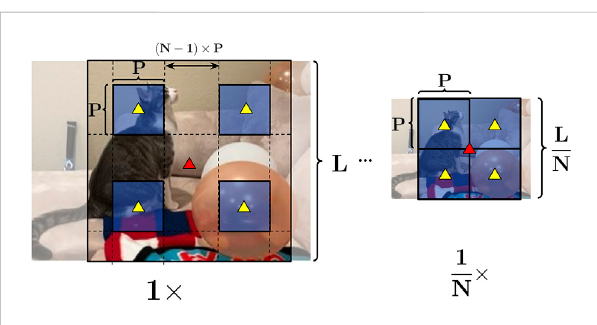
FIGURE 4 Multi-resolution patch sampling. We fi rst rescale the N frames to , L for the shorter side and uniformly sample grid of patches L , ... , 2 L N N from the multi-resolution frames. P is the patch size. Patches are spatially aligned. The patches at the same location in the grid provide a multi-scale view for the same